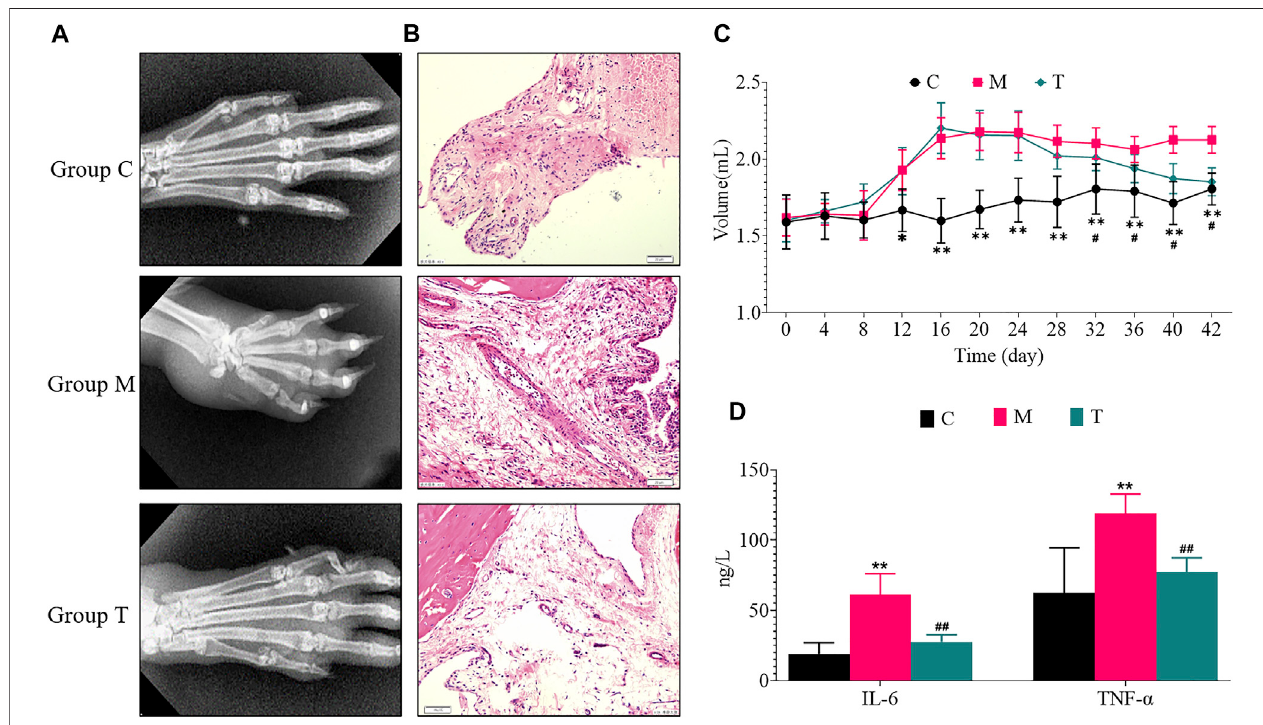
FIGURE2| Evaluationoftheeffectofwutoudecoctiononadjuvant-inducedarthritisrat. (A) X-rayexamination (B) Synovialhistopathologicalexamination(*200) (C) changes in paw volume before and after administration (D) Determination of in fl ammatory factors in serum. Results are expressed as mean ± SD, n = 8. * p < 0.05, ** p < 0.01 vs control group. # p < 0.05, ## p < 0.01 vs model